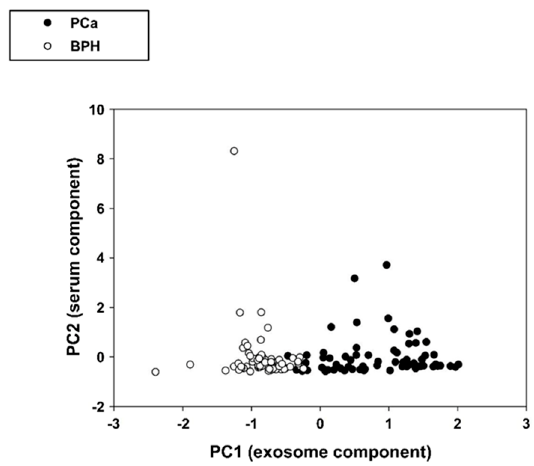
Figure 2. Projection (component scores) of the patients in the bi-dimensional space spanned by the two principal components (PC1 = exosome component and PC2 = serum component).